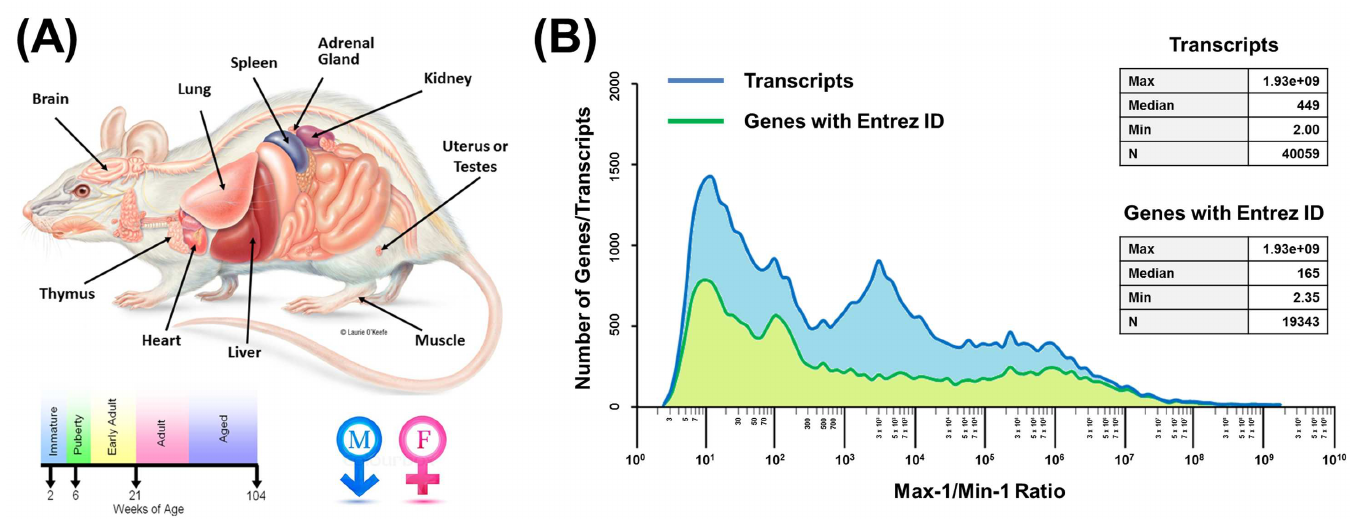
Fig 1. Study design and gene expression stability. (A) 320 organ samples were collectedfrom rats of different ages and sexes. (B) A total of 19343 unique geneswith Entrez ID were refined from 40059 transcripts. The distributionof expression changes demonstrated the rarity of geneswith low variationacross